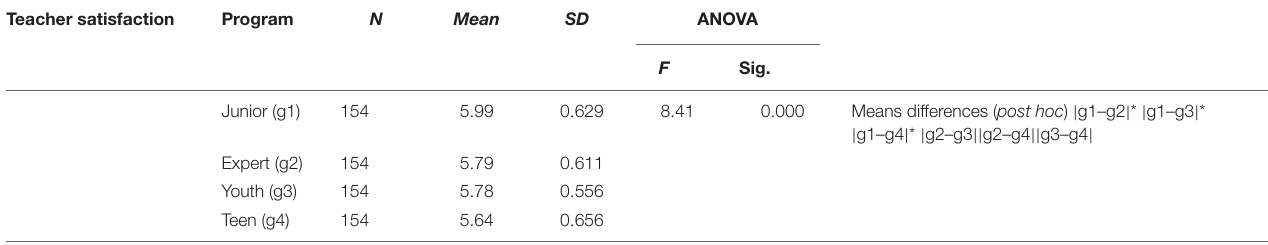
*Significant means difference at 0.05 level. TABLE 3 | Students’ personal skills among four programs (Anova and post hoc ). Motivation